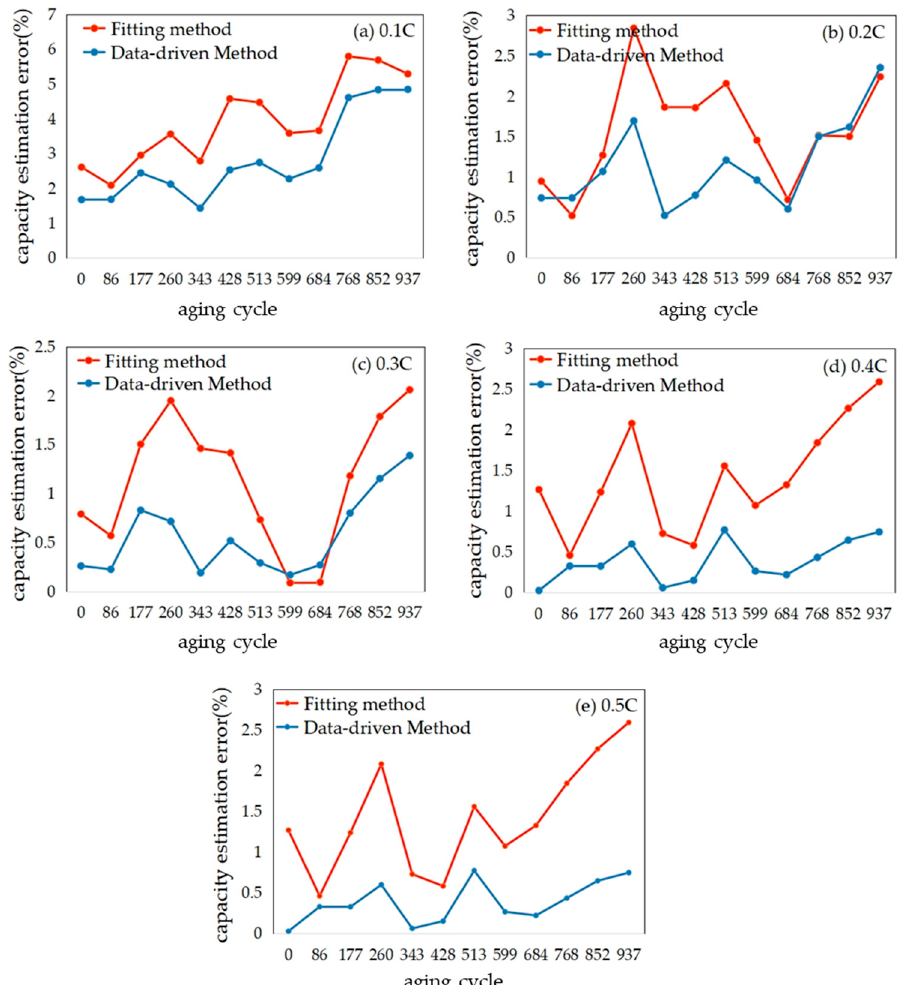
Figure 6. Accuracy comparison of two methods considering charging current. Table 3. Comparison of the average error and RMSE of the two methods.